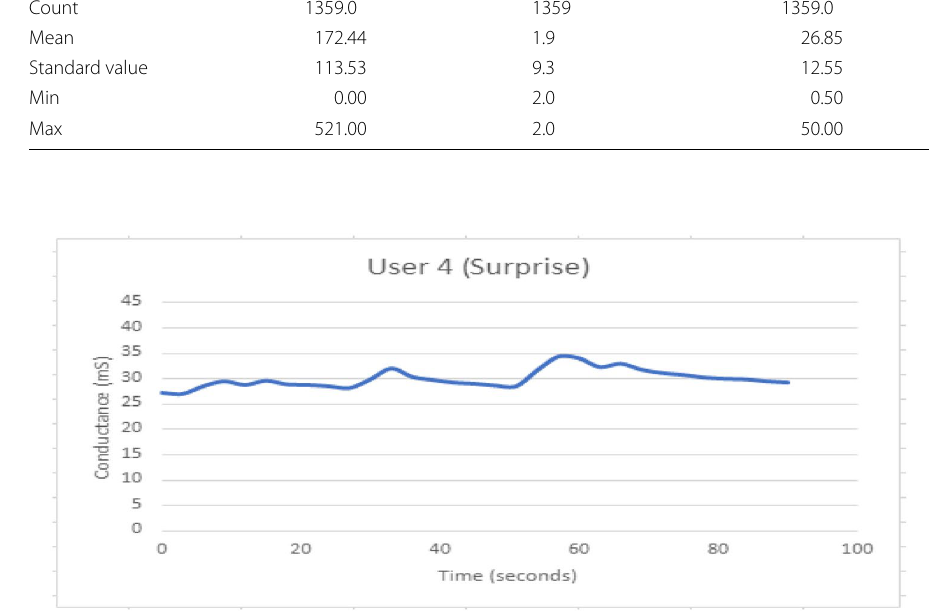
Fig. 21 GSR response when participant 4 is experiencing Surprise